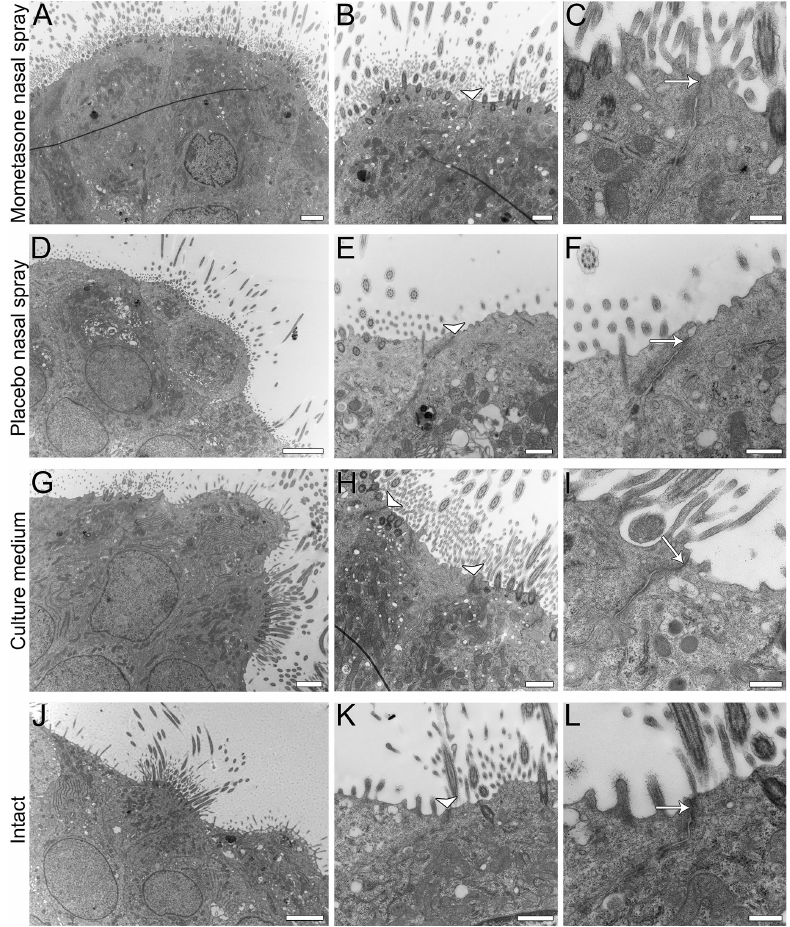
Figure 8. Post-treatment ultrastructural TEM analysis of the nasal MucilAir TM in vitro models. Cultures were treated with 10-fold diluted mometasone nasal spray ( A – C ), 10-fold diluted placebo nasal spray ( D – F ), or culture medium ( G – I ) for 14 consecutive days. Intact cultures were not treated ( J – L ). Ciliated and non-ciliated cells are connected with junctional complexes (arrowheads in B , E , H , K ) in all MucilAir TM cultures (treated and untreated). Well-formed tight junctions are seen in higher magnifications (arrows in C , F , I , L ). Scale bars, 6 µm ( D ), 4 µm ( J ), 2 µm ( A , G ), 1 µm ( B , E , H , K ), 600 nm ( F ), and 400 nm ( C , I , L ).